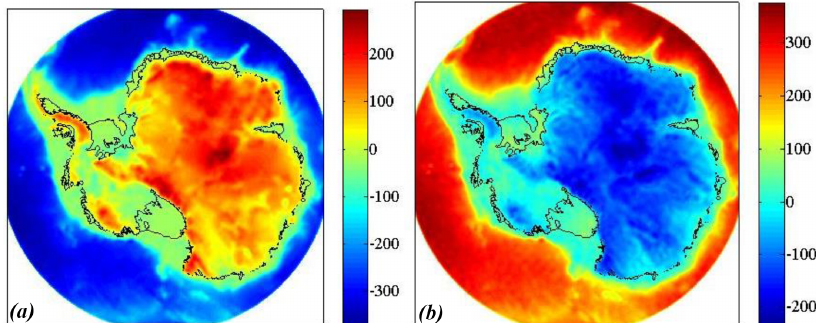
Figure 4. (a) Gravitational terrain effect derived from BEDMAP ice thickness, sea and bedrock topography. A low-pass filter of 77km cutoff is applied. (b) Bouguer anomalies estimated as the difference between GOCE observed free air anomalies and terrain effects (in mGal).